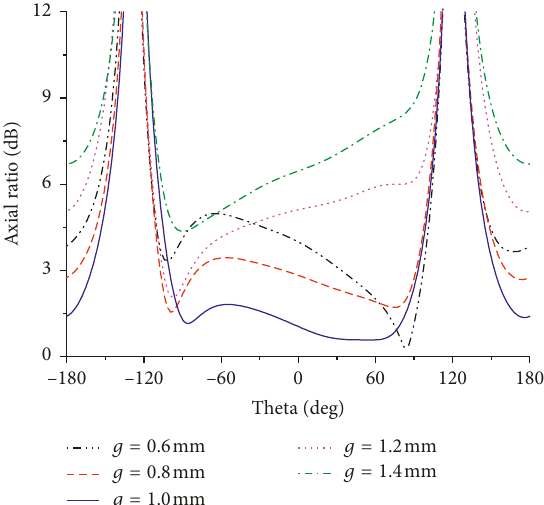
Figure 7: The AR against theta at phi � 0 deg plane when tuning the gap width g